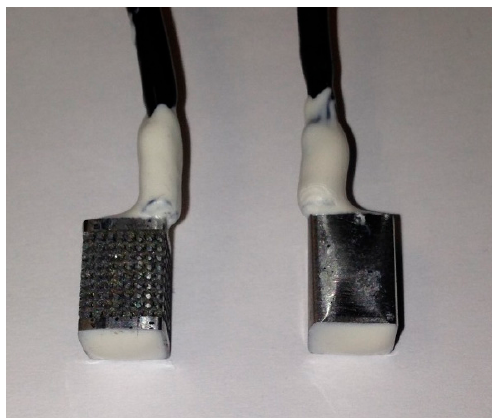
Figure 3. The epoxy molding of the bulk and porous samples and exposed surfaces after the electrochemical corrosion test in SBF.